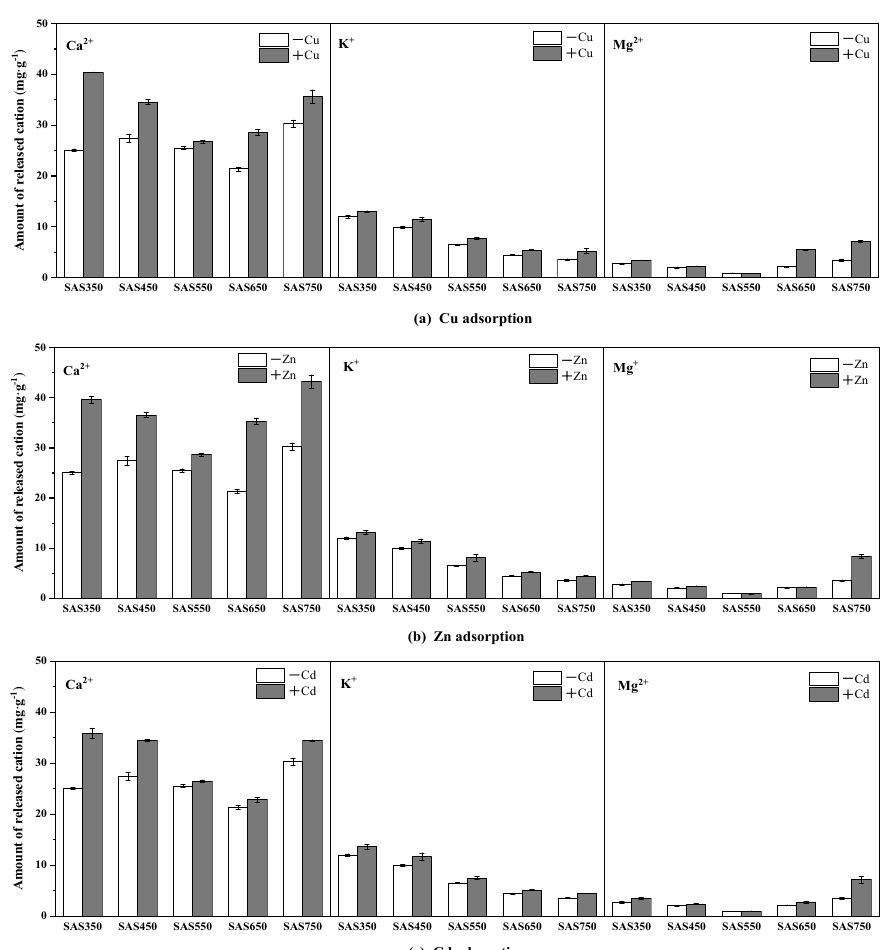
Figure 6. The amount of Ca 2+ , K + , and Mg 2+ released from spent Agaricus bisporus substrate biochars (SABCs) into solution before and after Cu(II) ( a ), Zn(II) ( b ), and Cd(II) ( c ) adsorption (pH of 5, 24 h, initial concentration of 100 mg·L − 1 and adsorbent dosage of 1 g·L − 1 ).